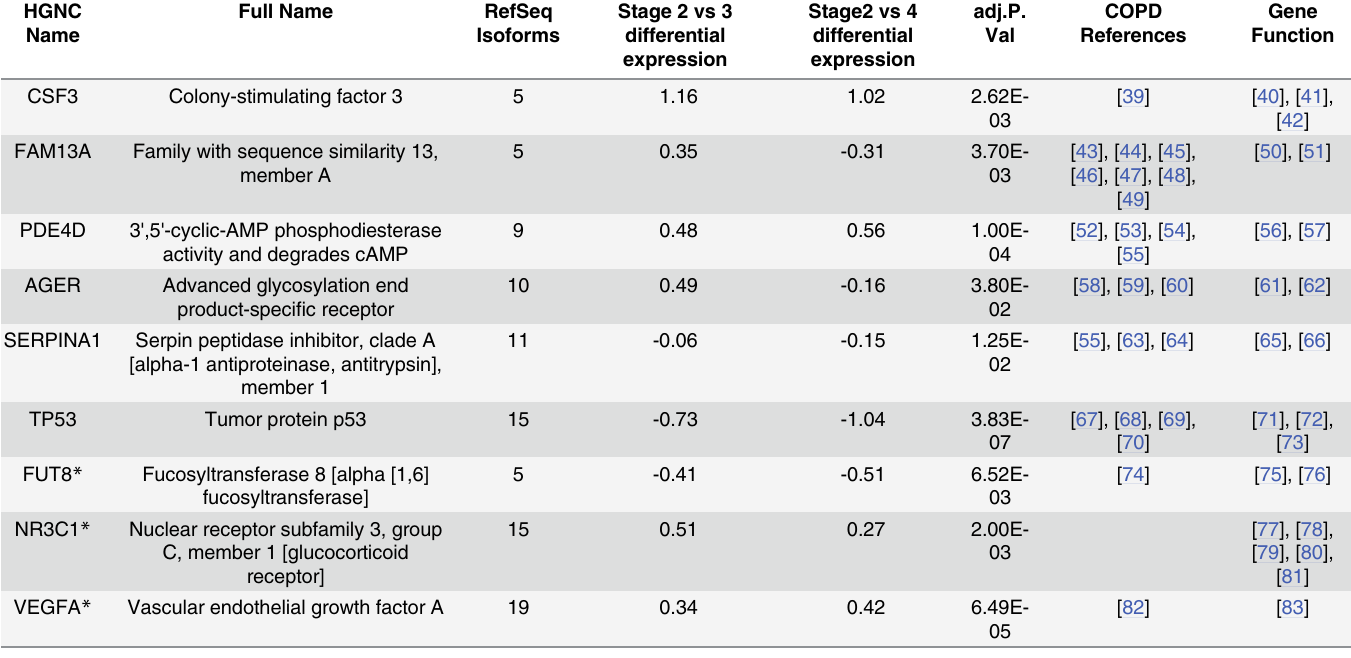
Table 1. Transcriptionally complex loci associated with COPD from genes expressed in stage 2 versus stages 3 and 4 COPD patients